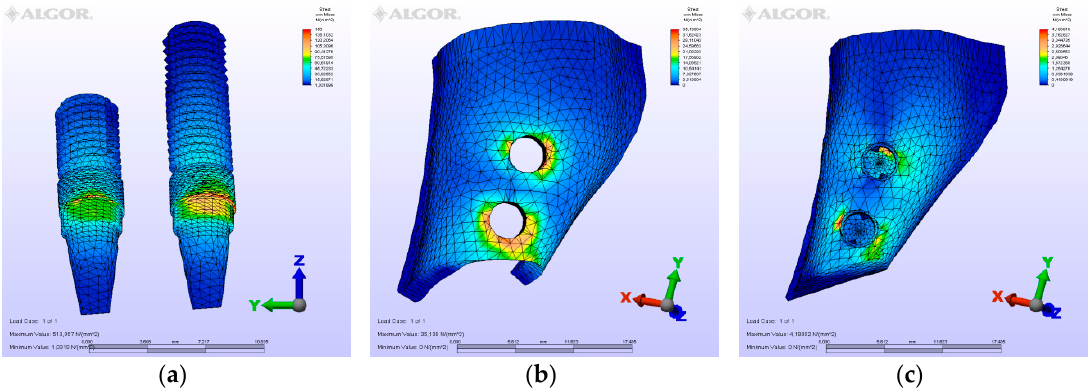
Figure 12. M4, oblique loading. ( a ) the maximum von Mises stresses around implants; ( b ) maximum principle stress in cortical bone; ( c ) maximum principle stress in cancellous bone.